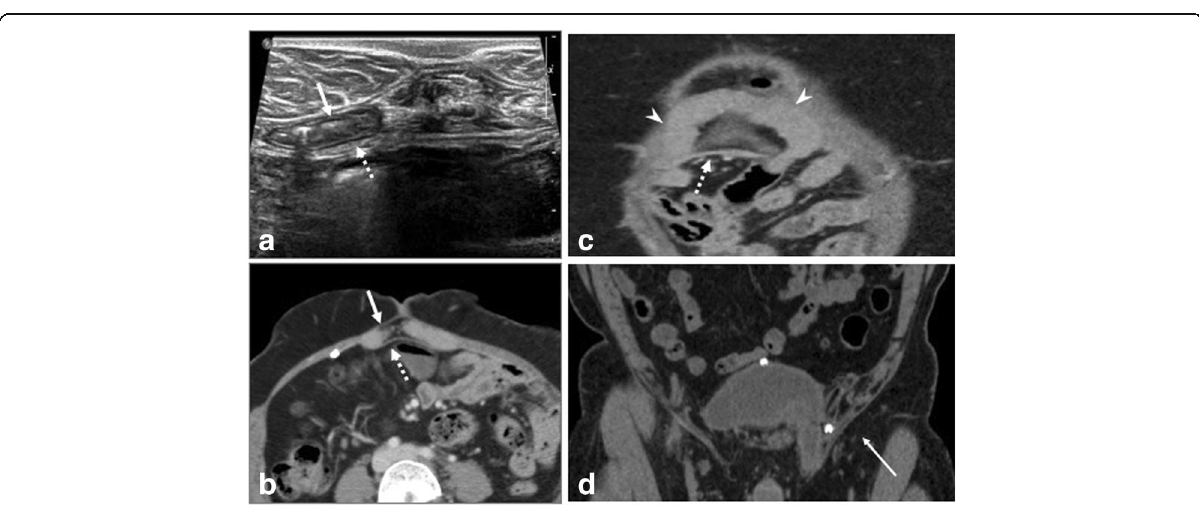
Fig. 10 a USG shows recurrent herniation of the small bowel between the mesh (dashed arrow) and the parietal wall (white arrow). b , c CECT axial and coronal planes confirm the same with a loop of bowel (arrowheads in c ) herniating between the inferior margin of the mesh (dashed arrow) and parietal wall (solid arrow). d Recurrent hernia containing urinary bladder (arrow) in a previously repaired inguinal hernia in